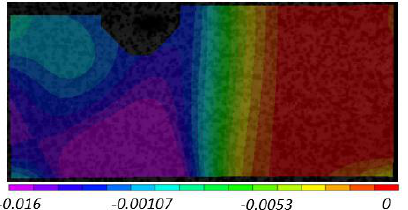
Fig. 4. Strain field of PMMA fragment launched at 116m/s